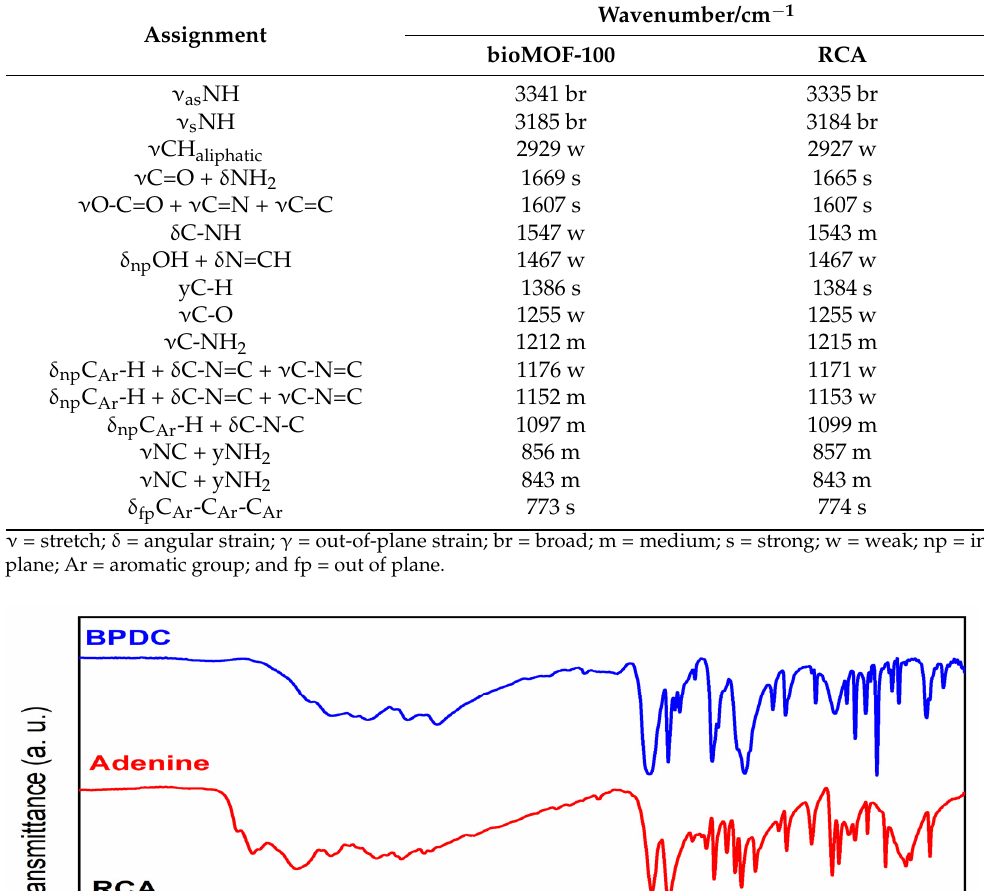
Table 1. Main frequencies in the infrared region of the material obtained (RCA) and that of the literature (bioMOF-100) [21].